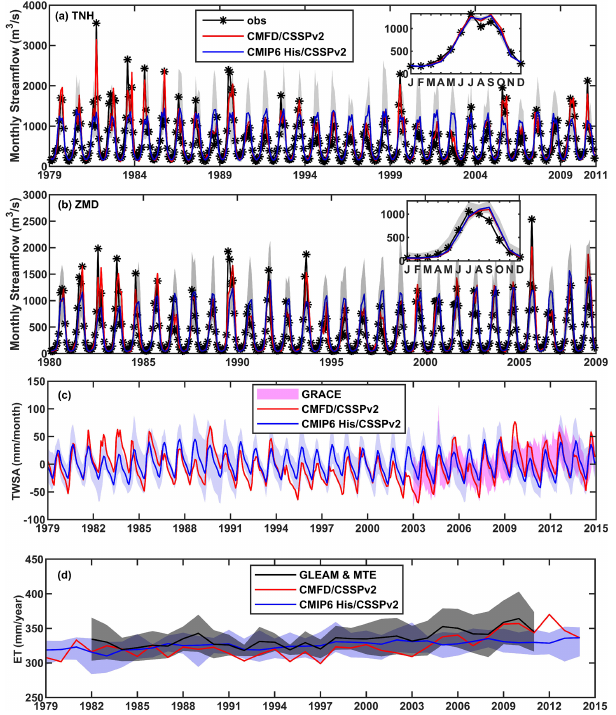
Figure 3. Evaluation of model simulations. (a–b) Observed and simulated monthly streamflow at the Tangnaihai (TNH) and Zhi- menda (ZMD) hydrological stations, with the climatology shown in the upper-right corner. (c–d) Evaluation of the simulated monthly terrestrial water storage anomaly (TWSA) and annual evapotran- spiration (ET) averaged over the Sanjiangyuan region. Red lines are the CSSPv2 simulation forced by observed meteorological forcing. Blue lines represent ensemble means of 11 CMIP6_His/CSSPv2 simulations, while gray shadings in (a) – (b) and blue shadings in (c) – (d) are ranges of individual ensemble members. Pink shading in (c) is GRACE satellite observations. The black line and black shading in (d) are ensemble mean and ranges of GLEAM_ET and MTE_ET datasets.